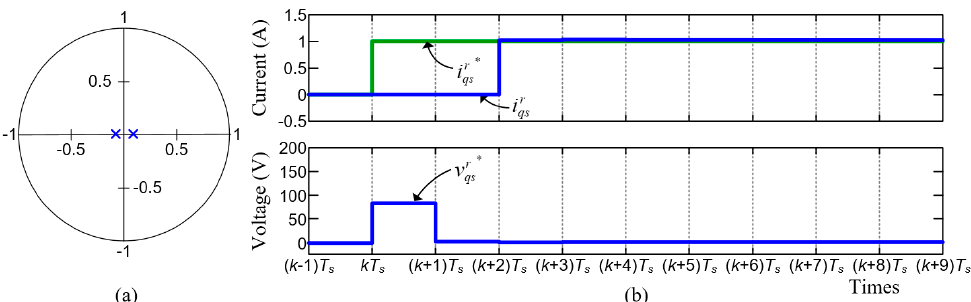
Figure 12. ( a ) The dominant poles and ( b ) simulated q -axis current and voltage command with ˆ r s = 1.5 r s when the current command steps from 0 A to 1 A. The motor is at standstill.